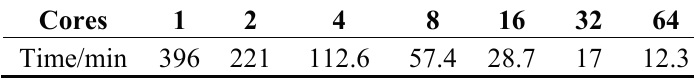
Figure 3. Time consumption of different number of ants. Table 2. Time consumption of different number of Cores.